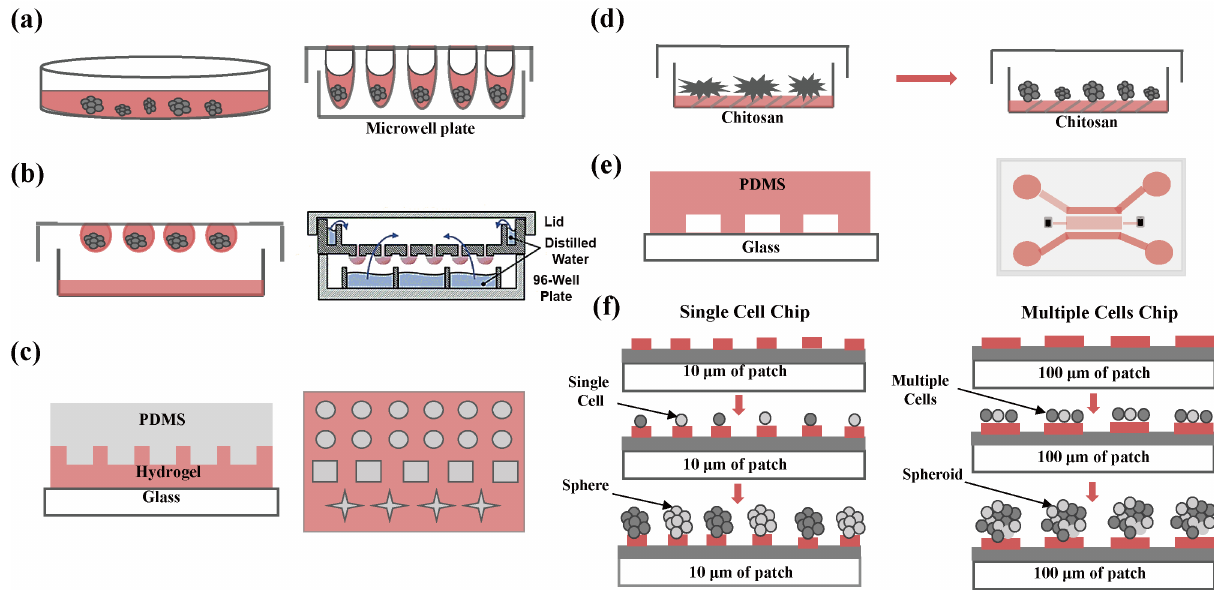
Figure 1. Methods used to generate MSC spheroids. (a) Overlay/Non-adhesive surface culture and ultra-low attachment microwell plates. (b) Gravity-induced spheroids by hanging drop culture and modified strategy (46). (c) Micropatterned substrates by micro-molding techniques using polydimethylsiloxane (PDMS). (d) Chitosan-mediated spheroid formation after transient adherence. (e) Microfluidic system (47). (f) Single cell derived sphere formation